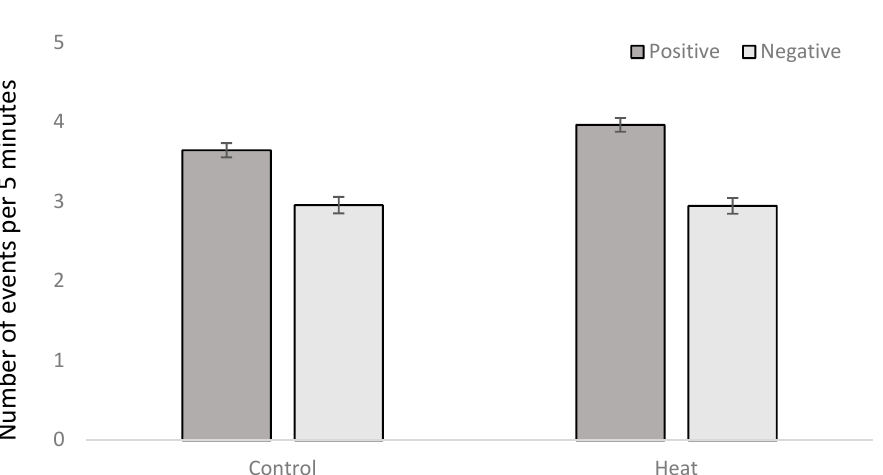
Figure 7. Mean ± SE of number of positive social interactions and negative social interactions per observational period of five minutes depending of the environmental temperature (control vs. heat).